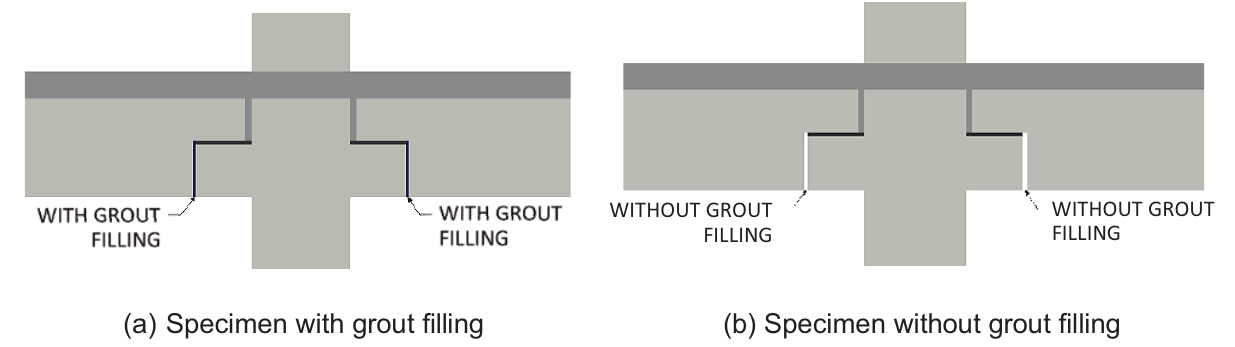
(a) Specimen with grout filling (b) Specimen without grout filling Grouting filling in the vertical interface between corbel and beam